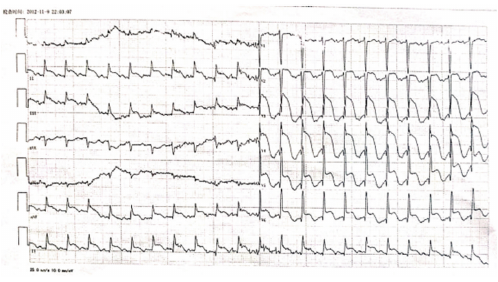
Figure 3: ECG 2 weeks after discharge from